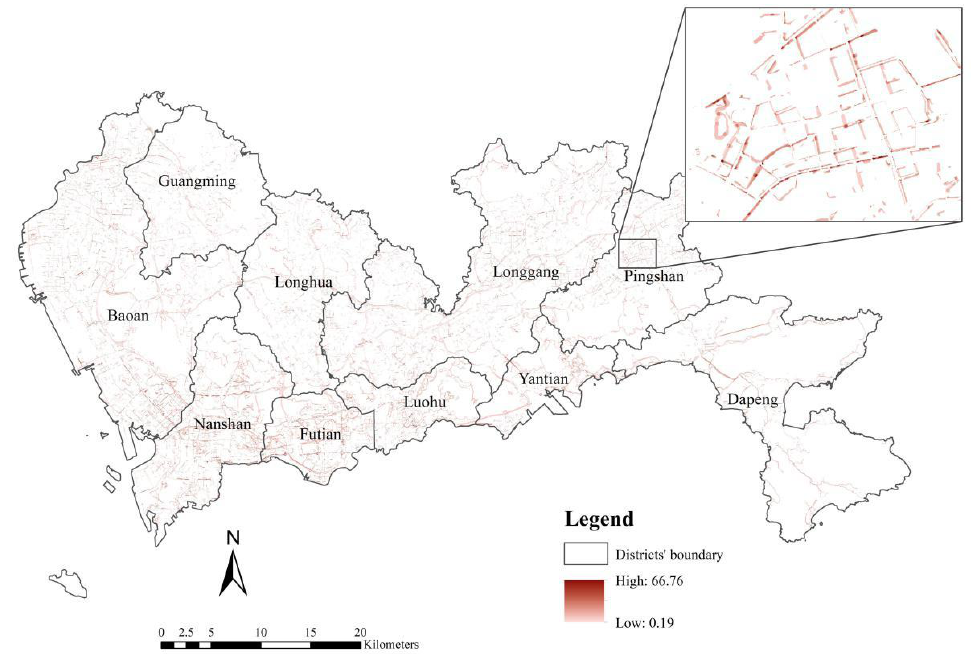
Figure 6. Product value of the noise reduction service of roadside green belts in Shenzhen (Mapping by IUEMS).